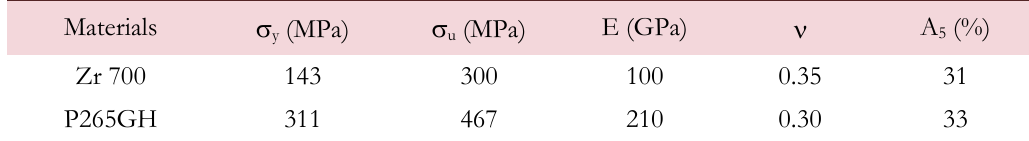
Table 1: Mechanical properties of Zr 700 and P265GH steel.